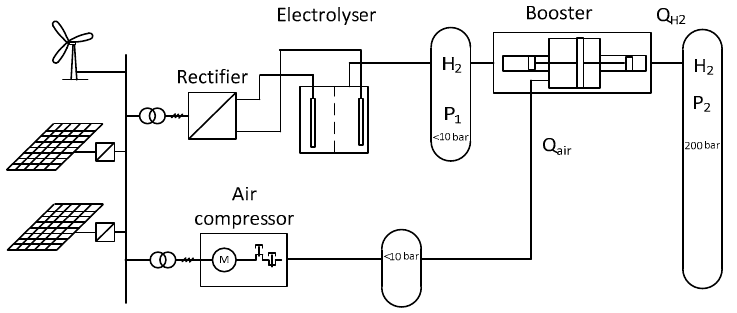
Figure 2. Example of a Hydrogen generation and storage facility.